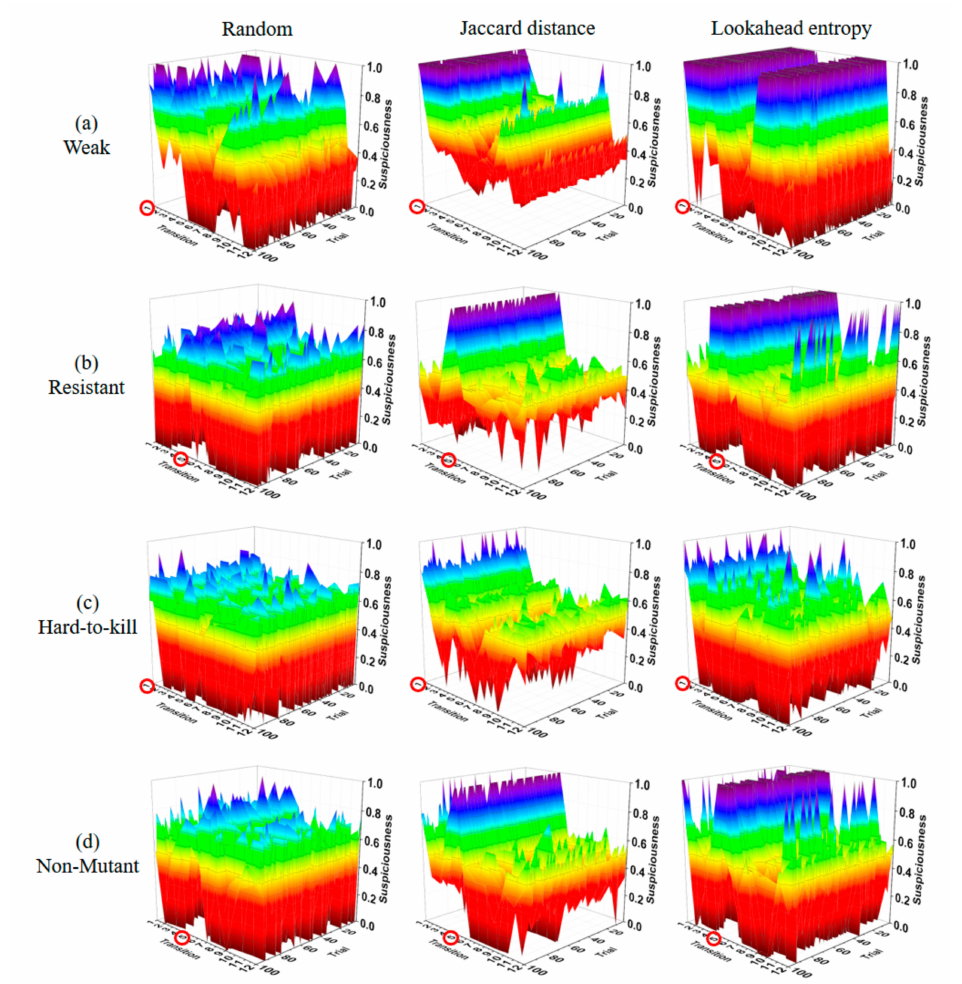
Figure 11. Suspiciousness of the whole transition (mesh state